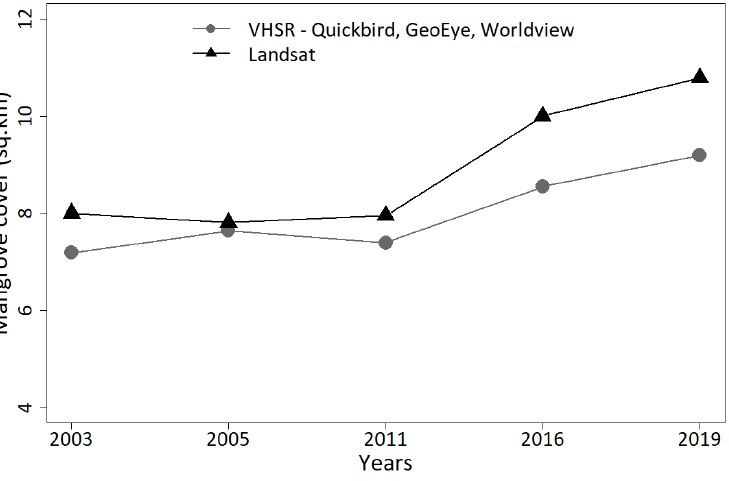
Figure 12. Comparison of mangrove cover as estimated by VHSR images (Quickbird, GeoEye, and Worldview) and Landsat.